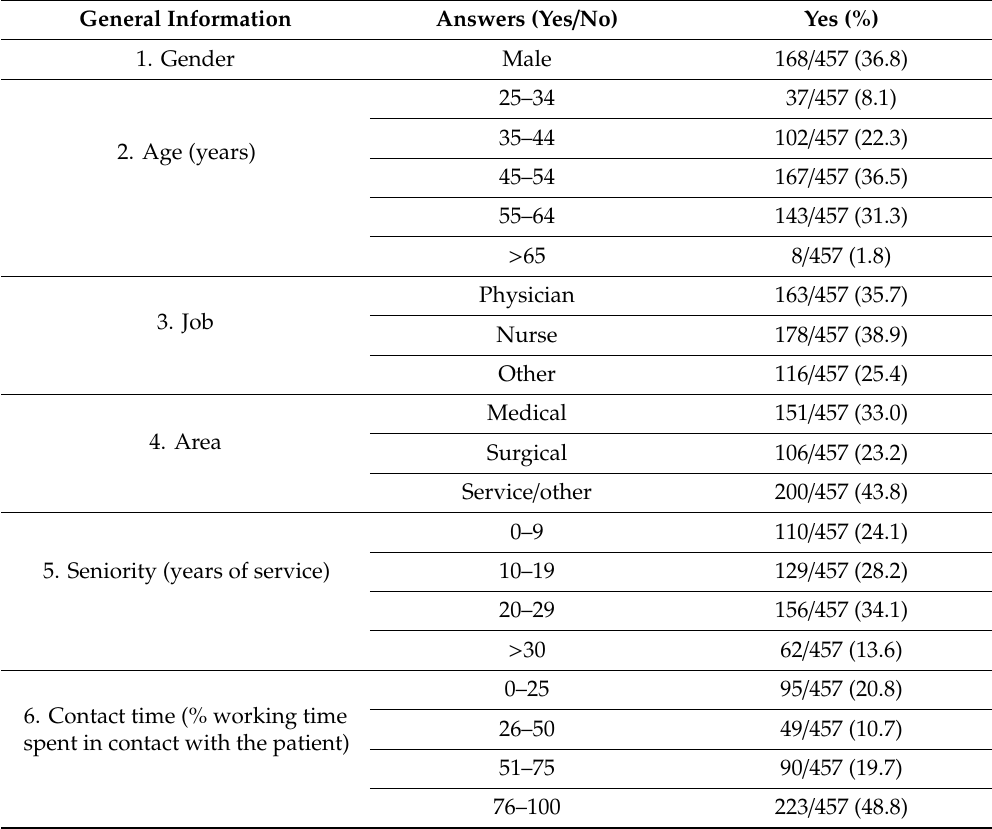
Table 1. Participants’ general